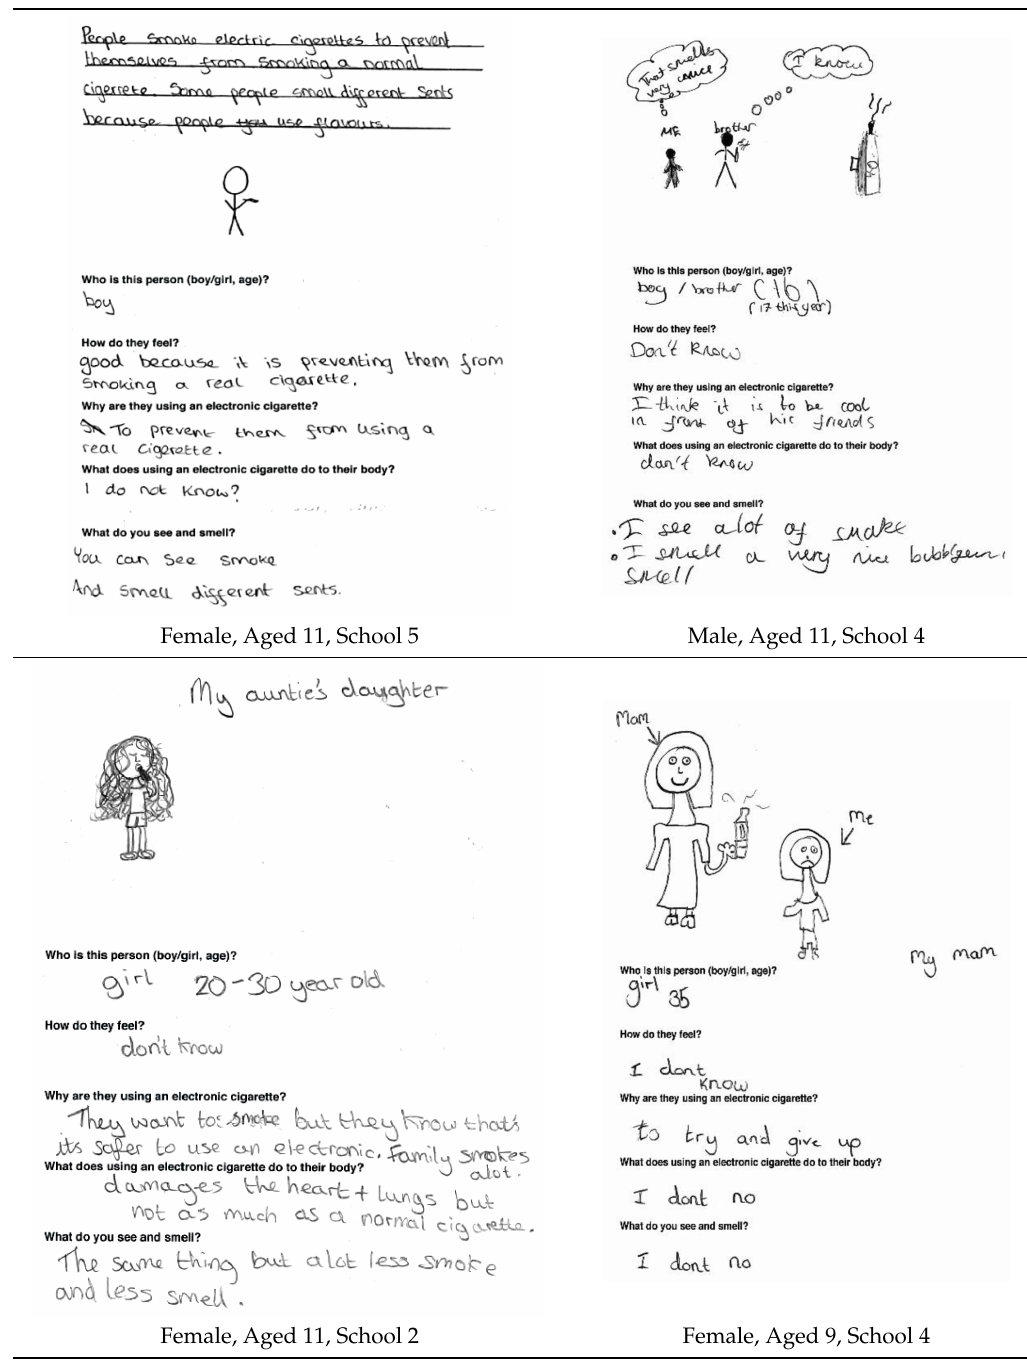
Table 3. Draw and Write Responses for e-cigarette